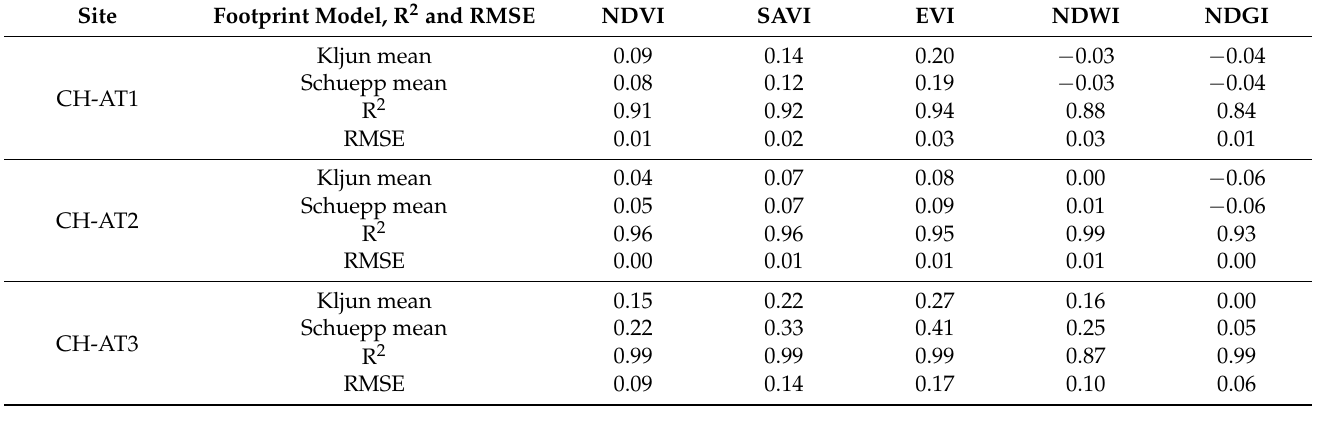
Table 4. Comparison between vegetation index (VI) values obtained with the footprints calculated with the Kljun et al. [57] and the Schuepp et al. [55] approaches. The mean values of each VI calculated with both approaches in the study period are presented. In addition, the coefficient of determination (R 2 ) and root mean square error (RMSE) between the results of the Kljun et al. [57] and the Schuepp et al. [55] approaches are shown.